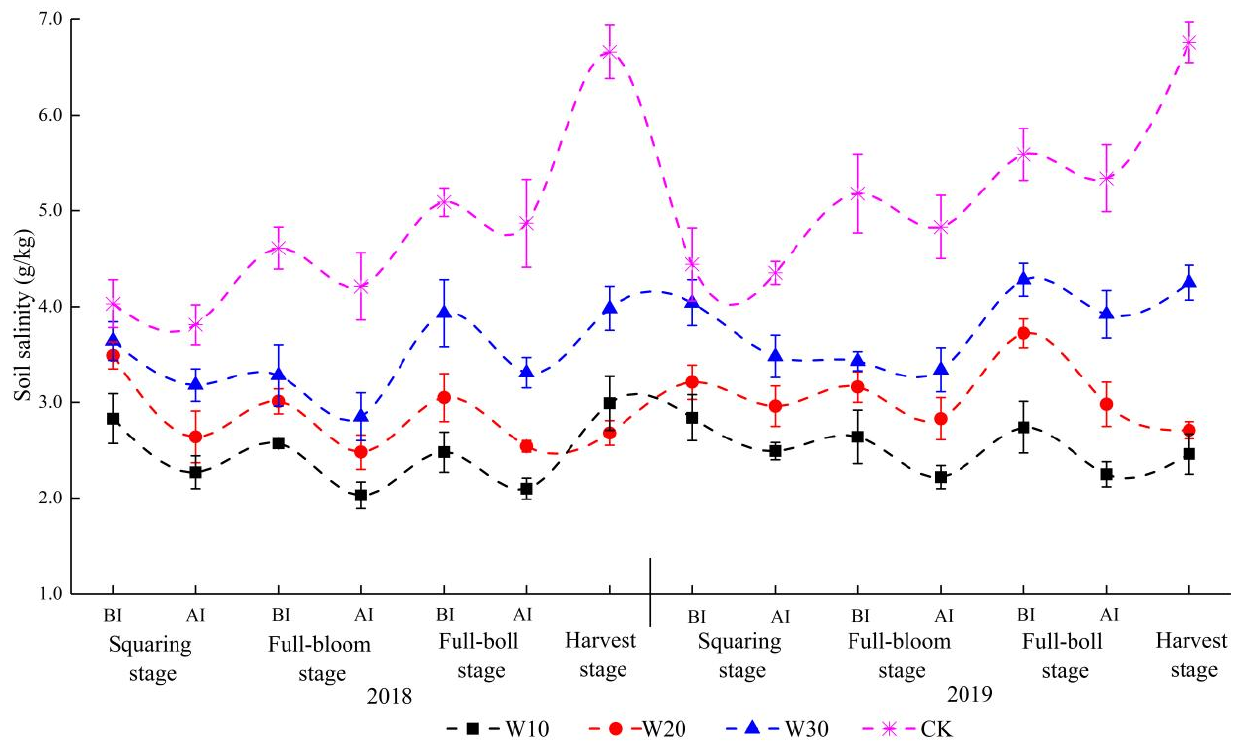
Figure 5. Soil salinity content before and after irrigation. W10, W20, and W30 mean the drain spacing of 10, 20, and 30 m, respectively. CK means no drainage. BI and AI mean before and after irrigation, respectively.